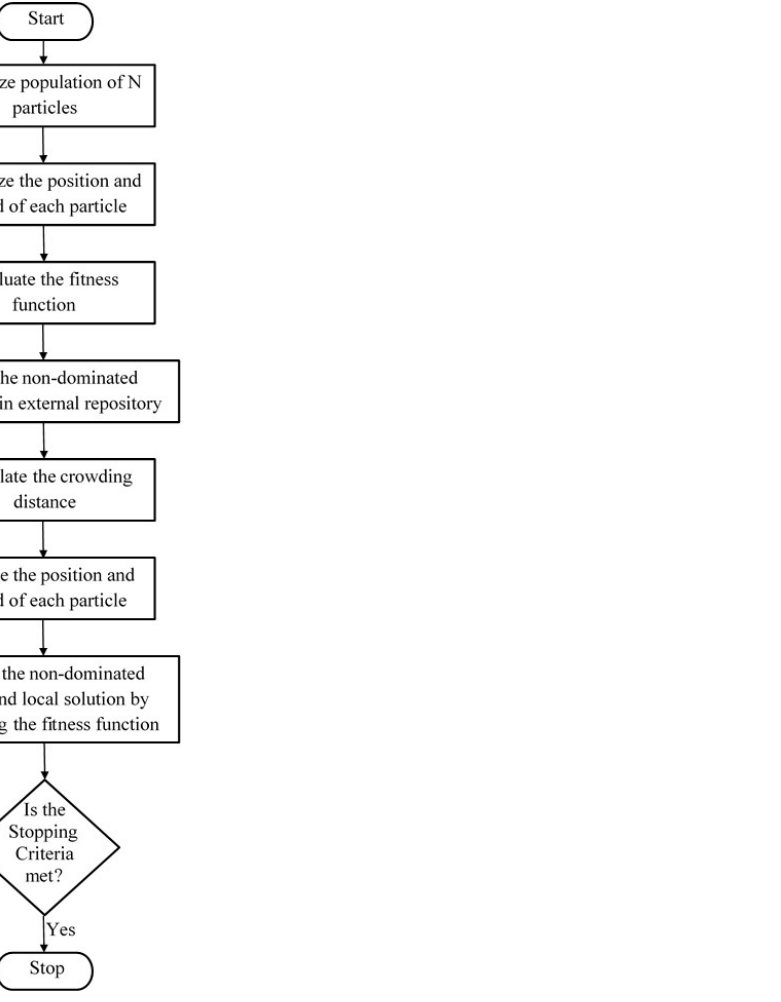
Figure 3. Flowchart for Multiple Objective Particle Swarm Optimization (MOPSO).